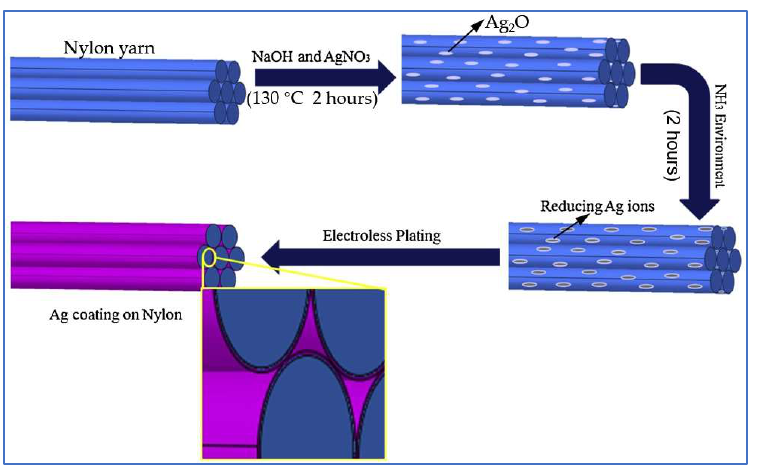
Figure 3. Schematic of preparation process of the flexible nylon/Ag conductive fiber via chemical plating [35]. plating